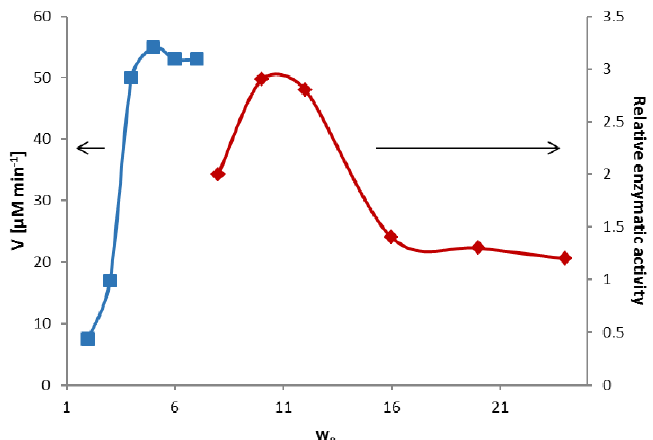
Figure 3. Variation in the enzymatic activity for the HRP ‐ catalysed oxidation of pyrogallol in ( ♦ ) W/O microemulsion consisted of isooctane/AOT/ n ‐ hexanol/buffer (25 mM phosphate buffer, pH = 7.0, z = 9.6) [46] and ( ■ ) a W/IL microemulsion consisted of [C8mim][Tf2N] (1 ‐ octyl ‐ 3 ‐ methylimidazolium bis(trifluromethylsulfonyl) amide)/AOT/1 ‐ hexanol/buffer (50 mM Tris buffer, pH = 8.0) [62]. AOT: Bis(2 ‐ ethylhexyl) sulfosuccinate sodium salt; IL: ionic liquid; z = [ n ‐ hexanol]/[surfactant].